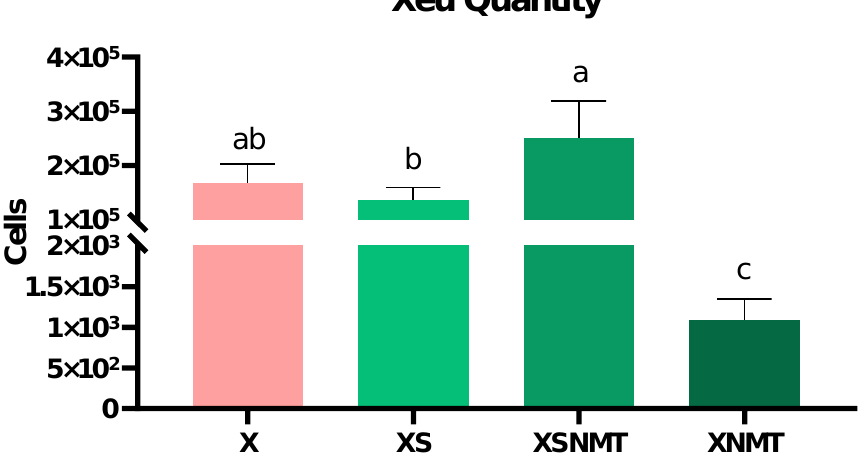
Figure 1. X. euvesicatoria amount in infected S. lycopersicum shoots, through q-PCR. Values are presented as mean ± SD ( n = 3). Means marked with the same letter are not significantly different according to the Dunnett test ( p < 0.05). X: infected untreated shoots; XS: infected shoots treated with S. montana EO; XSNMT: infected shoots treated with S. montana EO + NMT formulation; XNMT: infected shoots treated with NMT.